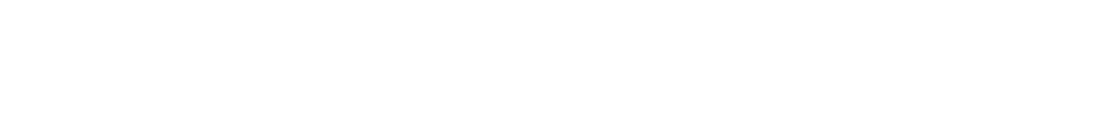
Frontiers in Physiology | Plant